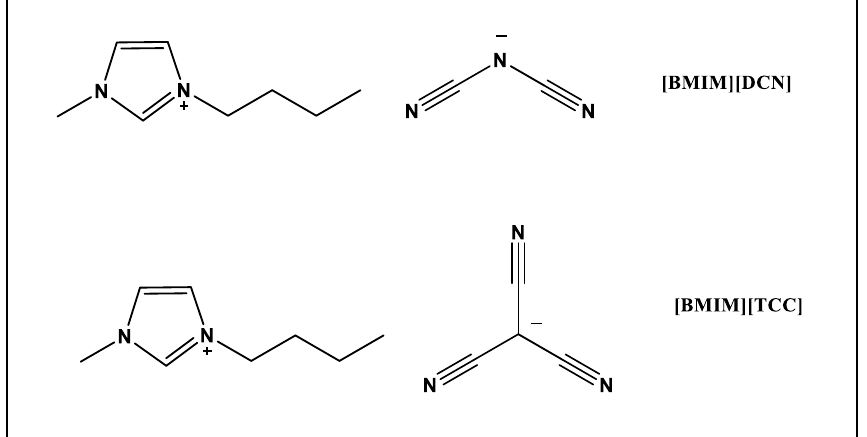
Figure 18. Chemical structure of [BMIM][DCN] and [BMIM][TCC]. Accurate surface analyses by Raman spectroscopy, atomic force microscopy (AFM) and time-of-flight secondary ion mass spectrometry (TOF-SIMS) highlighted a superior protection activity of the tested contacting surfaces (i.e., a smoother surface and a lower friction) by using [BMIM][TCC] when compared with [BMIM][DCN]. The probable ex- planation of this phenomenon is due to the major adsorption of CN groups inside and outside the wear tracks of the tested surface, which for the [BMIM][TCC] is four times higher than the [BMIM][DCN]. The friction probably causes the thermal decomposition of [BMIM][TCC], generating isolated CN anions covering the H-free-DLC surface. In 2019, to overcome the wear and corrosion problems due the corrosive hydrogen fluoride formed by the degradation of the fluorinated ILs in the presence of water, an ionic liquid formed from a fluorinated phosphonium cation and a dicyanamide anion (tributyl- 3,3,4,4,5,5,6,6,7,7,8,8,8-tridecafluorooctylphosphonium dicyanamide (see structure in Fig- ure 19)) was studied at room temperature and at various levels of relative humidity [136]. Figure 19. Chemical structure of the ionic liquid formed from a fluorinated phosphonium cation and a dicyanamide anion. The results showed that the simultaneous presence of fluorine and phosphorus on the IL cation provided good lubricant properties conferred from the halogen presence and high corrosion-inhibiting properties due to the phosphonium group. To be clear, water was actually found to be a fundamental key to promoting the formation and growth of a tribolayer between steel contacts, because tests carried out in the presence of dry air showed a film limited only to the border of the contact area.